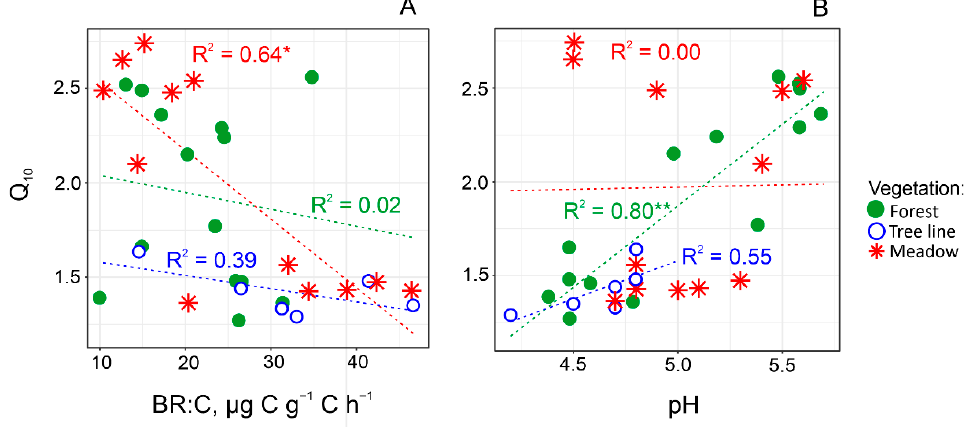
Figure 4. Relationship between temperature sensitivity of soil organic matter decomposition (Q 10 ) and BR:C, respiration per unit of soil C ( A ) and pH value ( B ) for mountain forests and meadows along long and short transects with different land uses ( n = 32; * p ≤ 0.01, ** p ≤ 0.001. One replication for mixed forest was removed due to pH outlier).